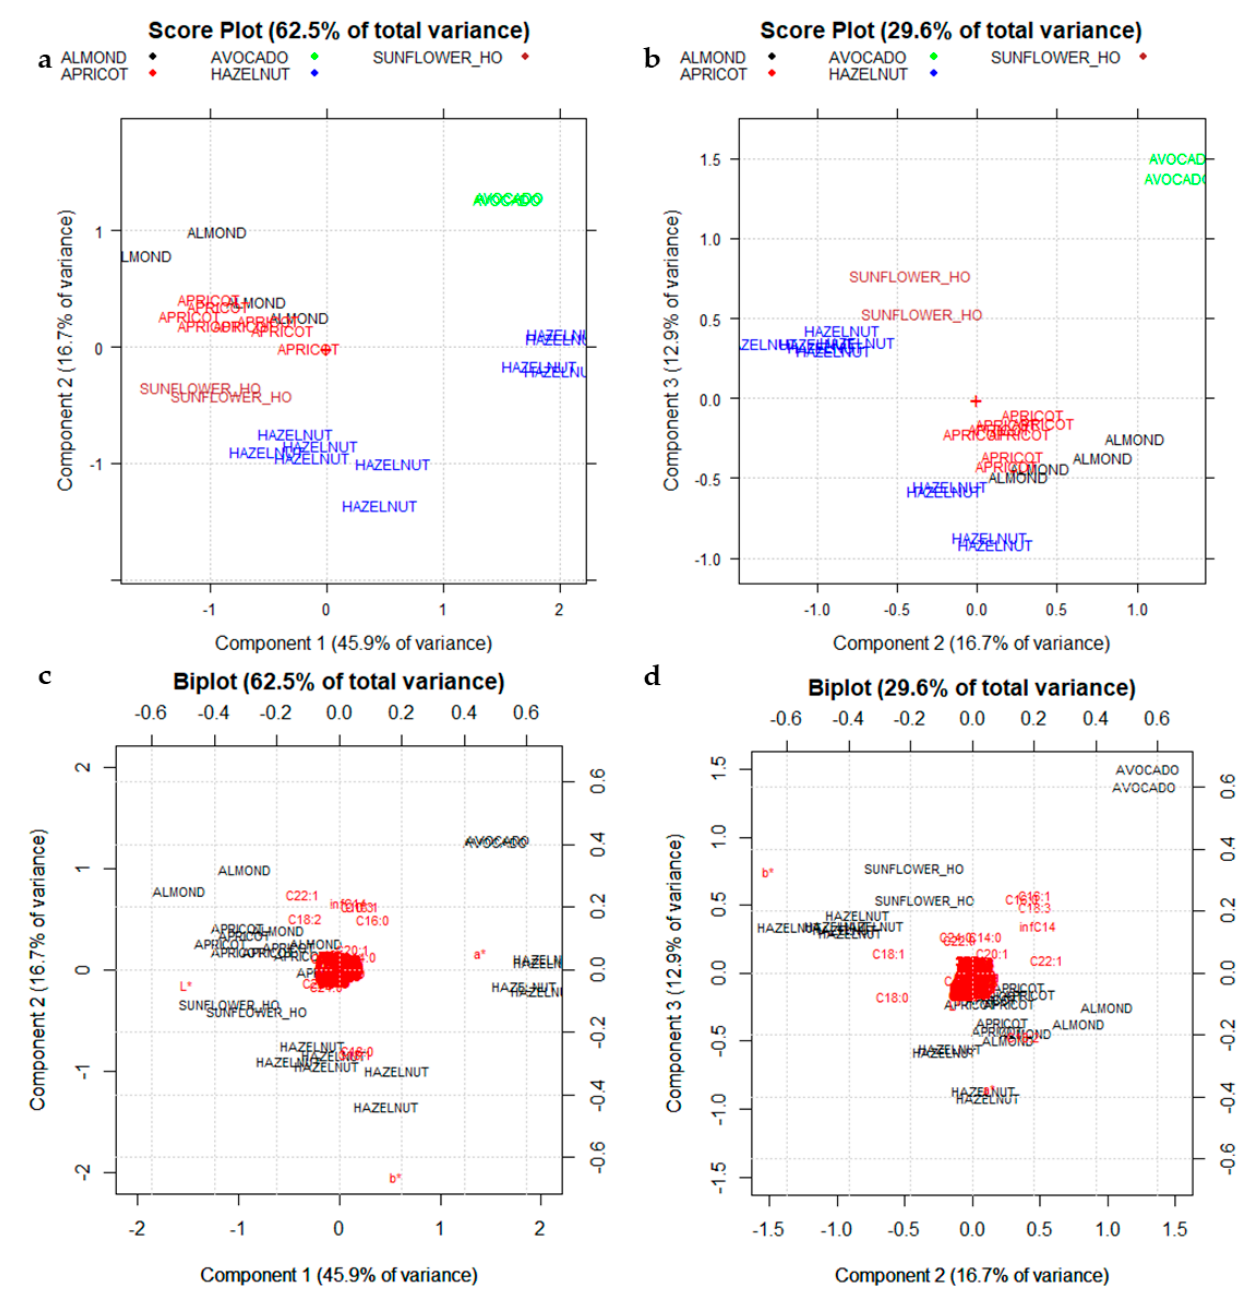
Figure 9. Score plots of the FAMEs composition, coupled to the raw spectral data after SNV pretreatment, and the CIELAB descriptors (data matrix I 28,418 ): ( a ) PC1–PC2 Score plot; ( b ) PC2–PC3 Score plot; ( c ) PC1–PC2 Biplot; ( d ) PC2–PC3 Biplot. + sign in the plots correspond to the origin (point 0,0). The three CIELab parameters: L* (lightness), a* (reddish–greenish), and b* (yellowish–bluish).